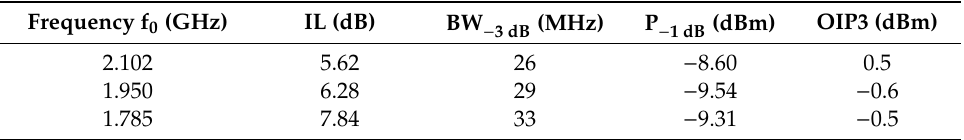
Table 1. Summary of measured results.